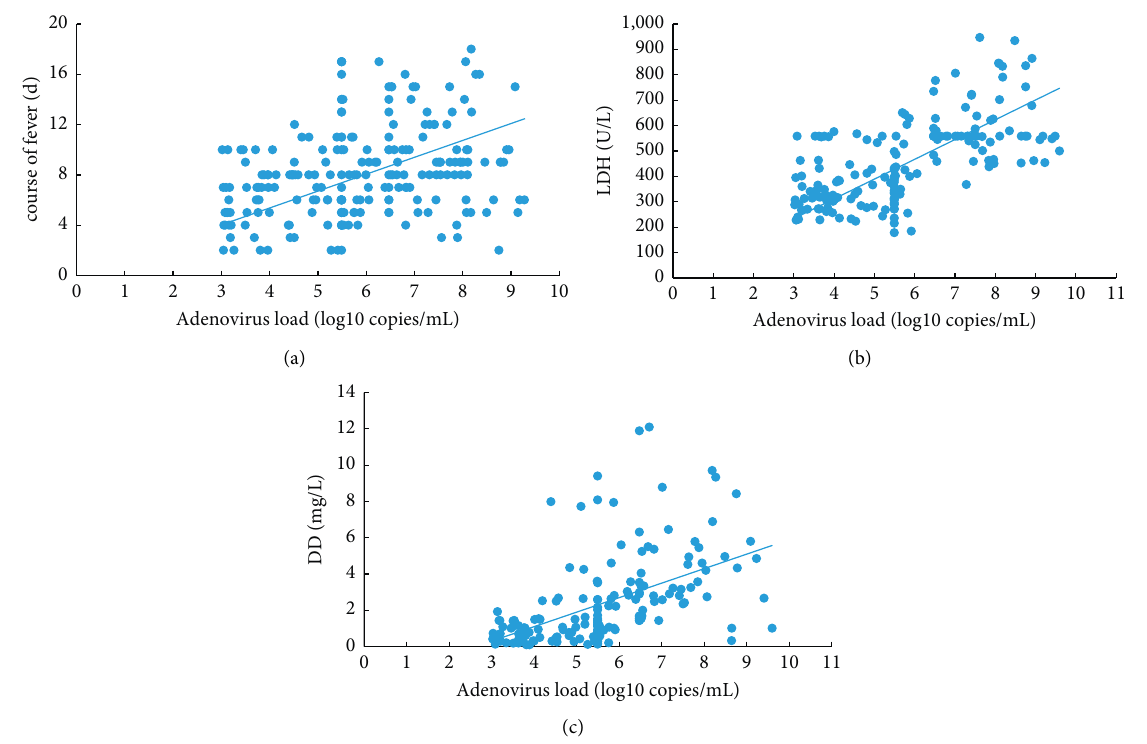
Figure 4: Correlation analysis among AdV load, heat range, LDH, and DD in the BMP group of children with AdV infection. (a) Correlation curve between AdV load and heat range in the BMP group ( R � 0.309, P � 0 . 003). (b) Correlation curve between AdV load and LDH in the BMP group ( R � 0.644, P � 0 . 001). (c) Correlation curve between AdV load and DD in the BMP group ( R � 0.531, P � 0 .